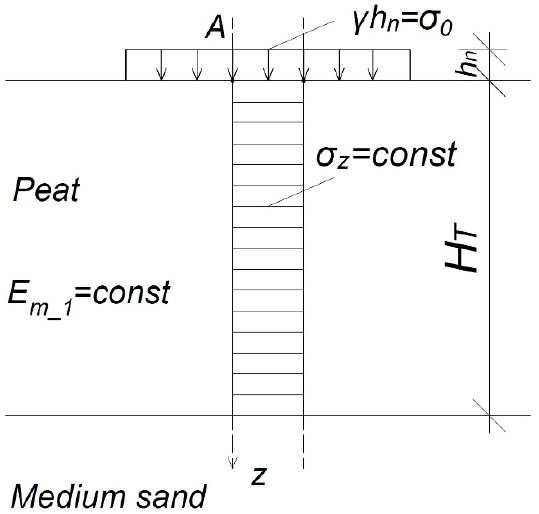
Figure 7. Computational organic soil column; σ 0 , loading by the preload embankment (kPa); σ z , stresses in the soil in the column under consideration (kPa); H T , organic soil thickness (m); E m_1 , constrained modulus of elasticity of peat material in the column under consideration; determined by the first model (kPa); A , analysed point ( − ); h n , the height of the embankment (m); γ , the weight of the embankment (kN m − 3 ); z , axis of depth.